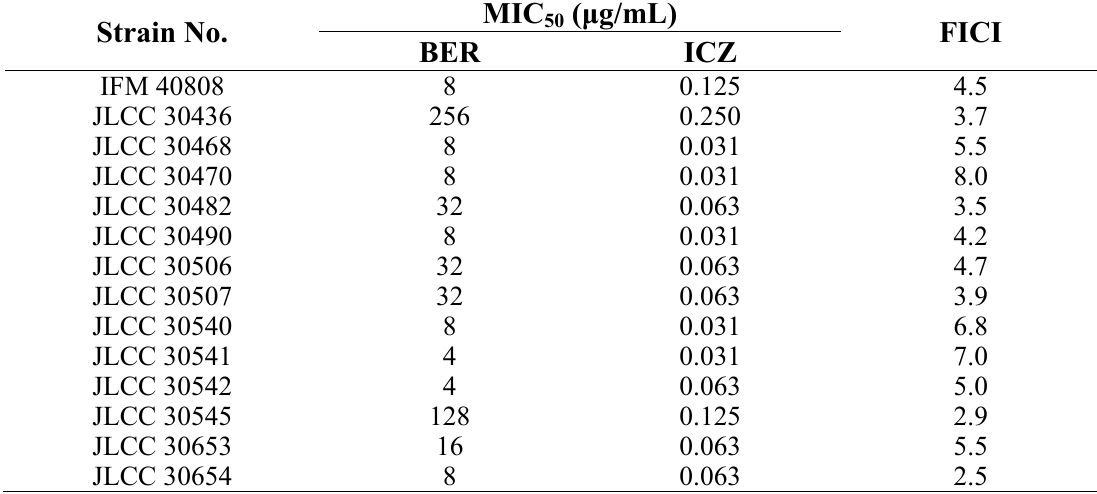
Table 1. Action of BER and ICZ alone (MIC , μ g/mL) or in combination (FICI value) 50 against A. fumigatus isolates from clinical patients. Drug interactions were tested using the checkerboard microdilution method at a final inoculum of 0.5–2.5 × 10 3 CFU/mL, using RPMI 1640 medium buffered with 0.165 M MOPS. Final drug concentrations ranged from 0.036–0.5 μ g/mL for ICZ and 1–128 μ g/mL for BER. Plates were incubated at 35 °C